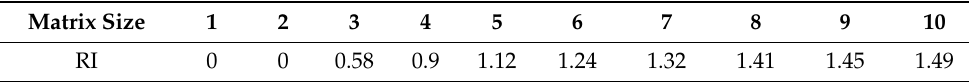
Table 5. Indicator values